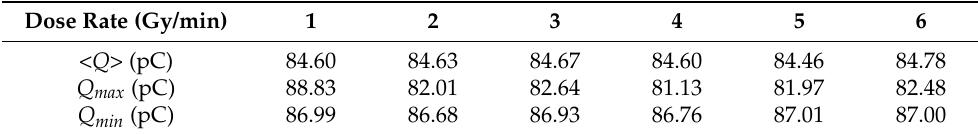
Table 1. Collected charge-per-pulse at different dose rates.